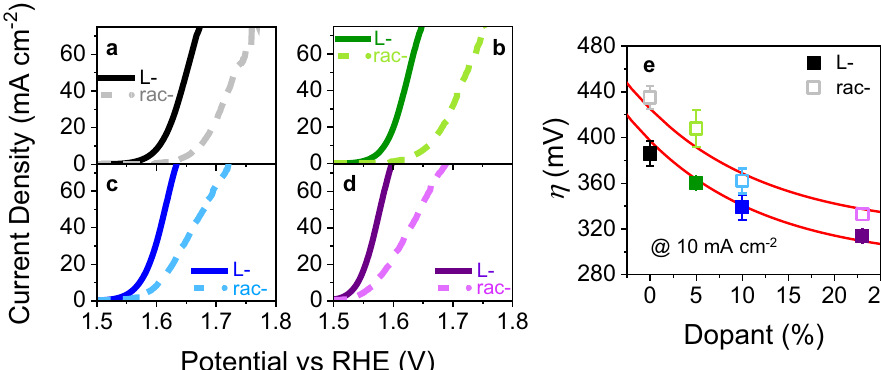
Fig.2|Voltammetricproperties.a – d Showslinearsweepvoltammogramsofundoped(black)and5%(green),10%(blue),and23%(purple)iron-dopedRac-(dashedline) andL-cobaltoxide(solidline)nanoparticlecatalystsinNa fi onmeasuredina1MNaOHelectrolyte. e Showsthecorrespondingoverpotentialat10mAcm-2forRac-(open symbols)andL-cobaltoxide( fi lledsymbols).Theredlinesareavisualguideforemphasizingtheeffectofchiralityandtheerrorbarsrepresentthestandarddeviationfrom at least three independent